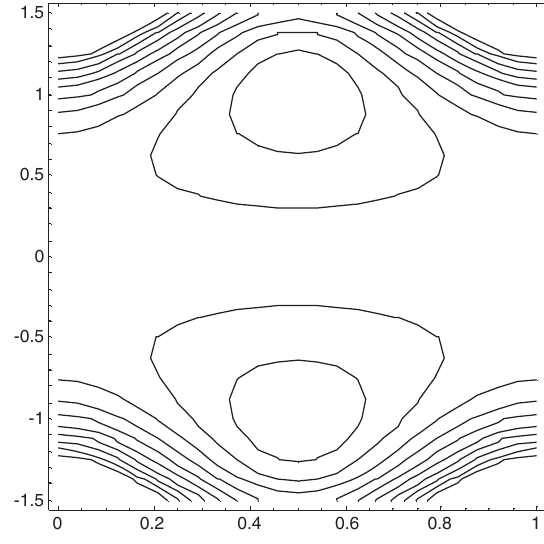
Fig. 17. Streamlines in the wave frame when Q =0.9, φ =0.6, M =1.0, N =0.25.